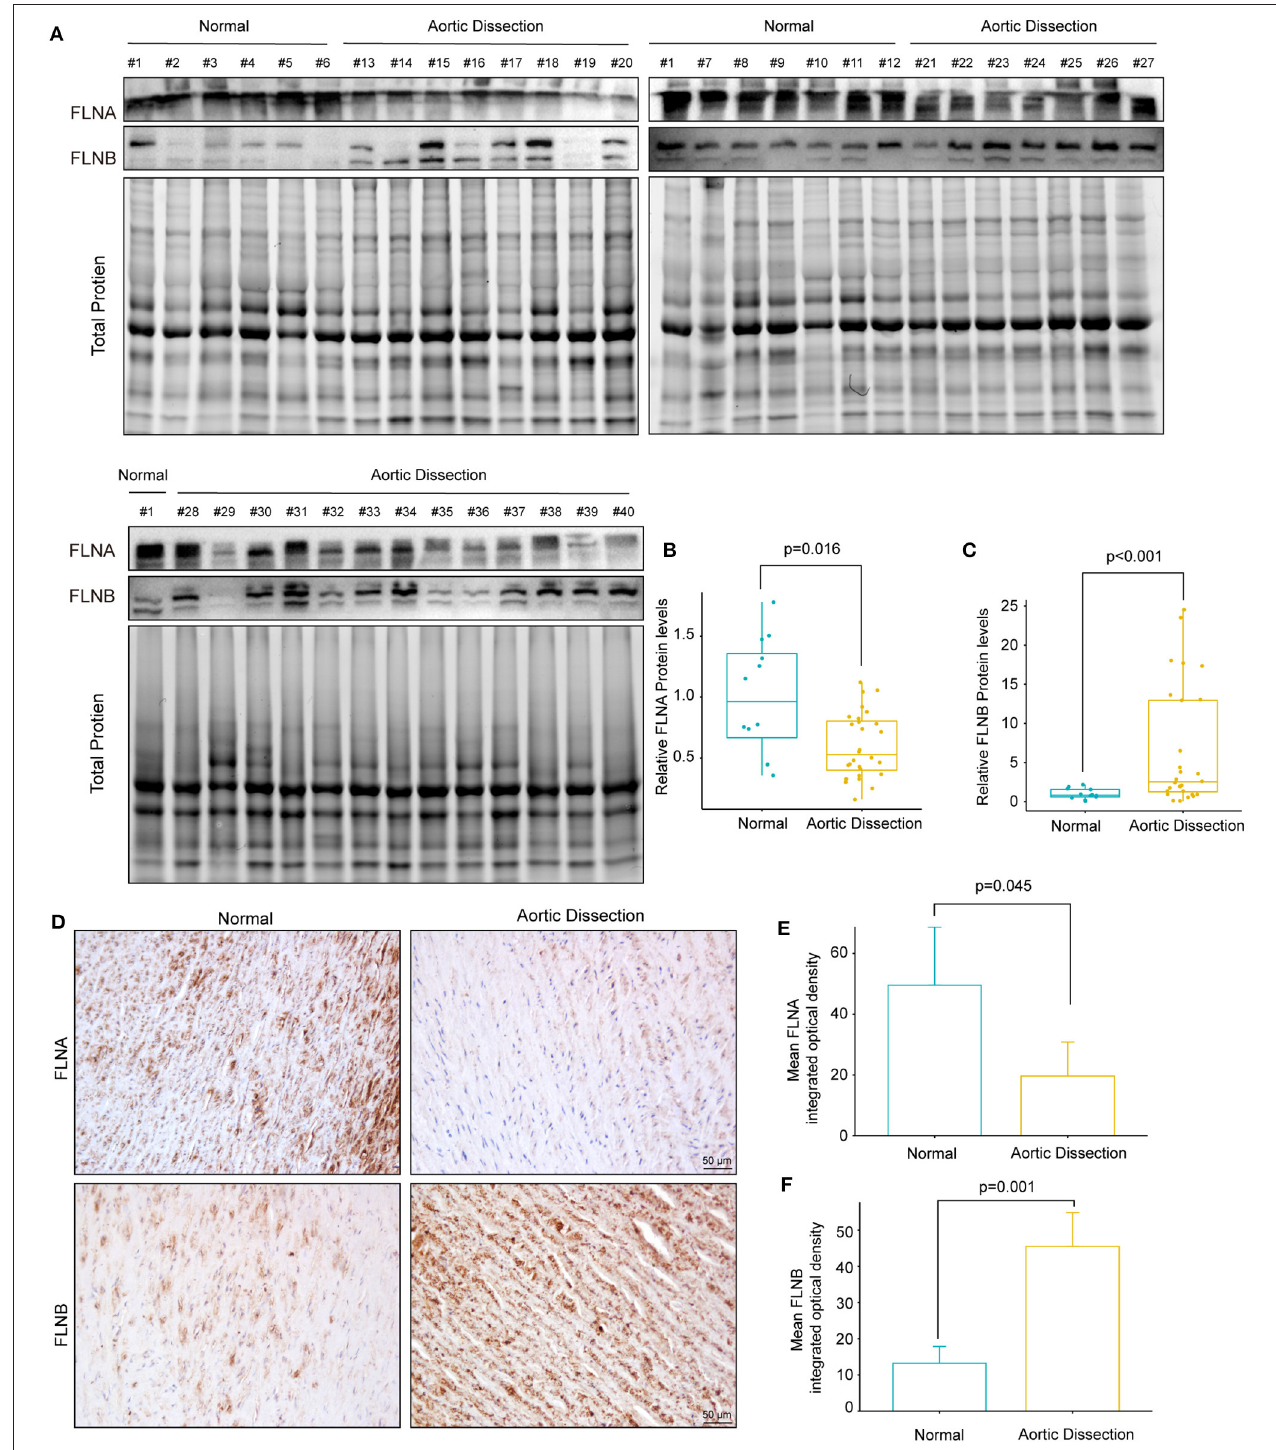
FIGURE 5 | The protein expression of FLNA and FLNB was completely opposite in human TAAD tissues. (A–C) Western blotting and quantitative results of FLNA and FLNB in aortic samples obtained from normal donors ( n = 12) and AD ( n = 28) patients. (D–F) Representative images of immunohistochemical staining and quantitative results of FLNA and FLNB in the aortic sections of normal and AD patients ( n = 3).